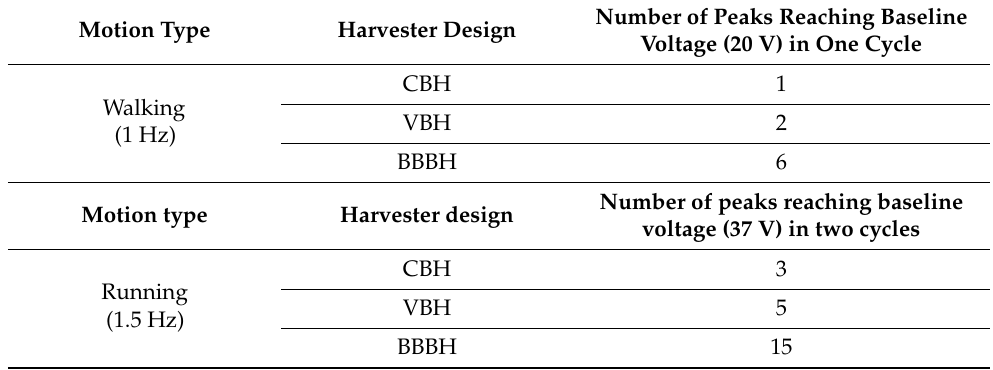
Table 9. The number of voltage peaks obtained in one motion cycle for walking and running